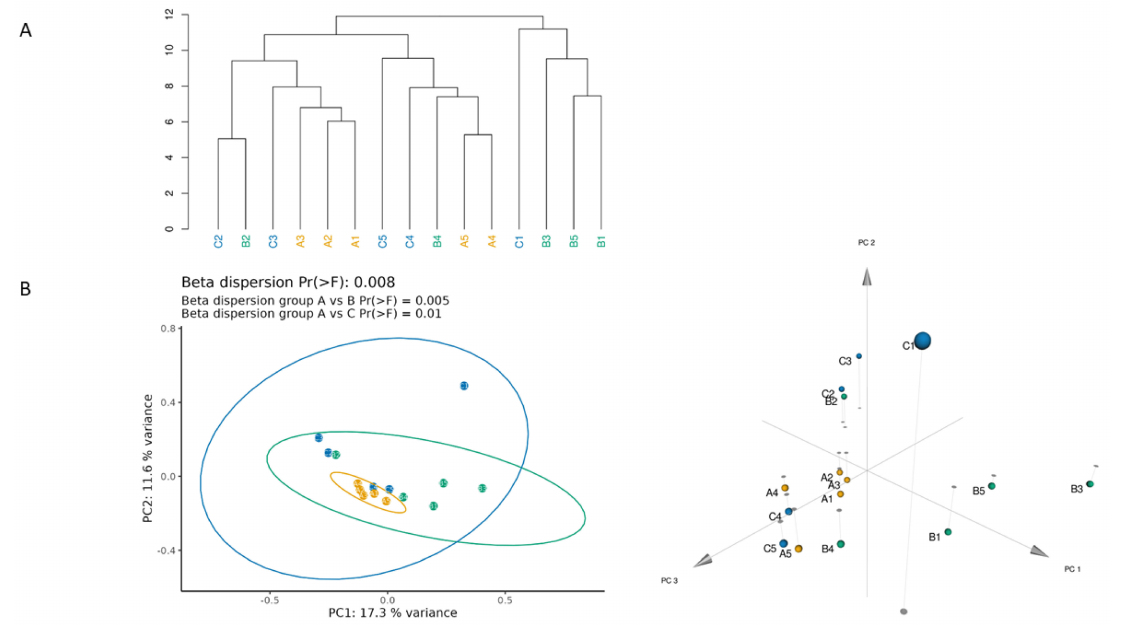
Figure 4. Multivariate representations of the entire sample set. ( A ) Complete hierarchical clustering based on Euclidean distance of square root transformed percent abundance of identified ASVs and ( B ) principal coordinate analysis using Bray-Curtis dissimilarity as a distance metric on square root transformed percent abundance of identified ASVs showing permuted p − value of general β dispersion and pairwise β dispersion of group A compared to groups B and C. Ellipses drawn around each group delineate the 95% confidence interval of the centroid position. Group A is plotted in yellow, Group B is in green, and Group C is in blue.